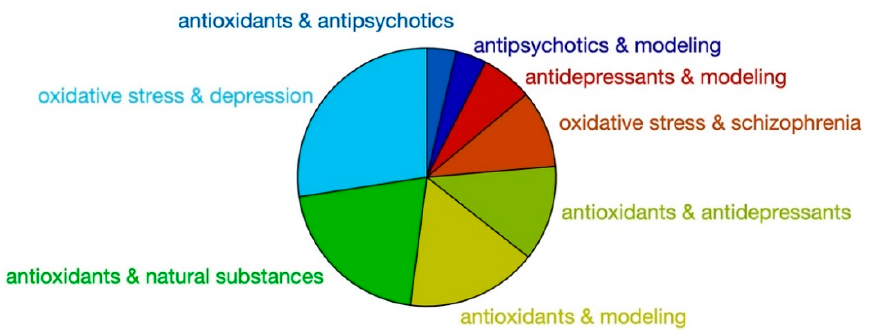
Figure 1. SCOPUS indexed works found with the shown keywords from 1990 (www.scopus.com, site accessed 10 July 2020). Sample size 16,075 documents.